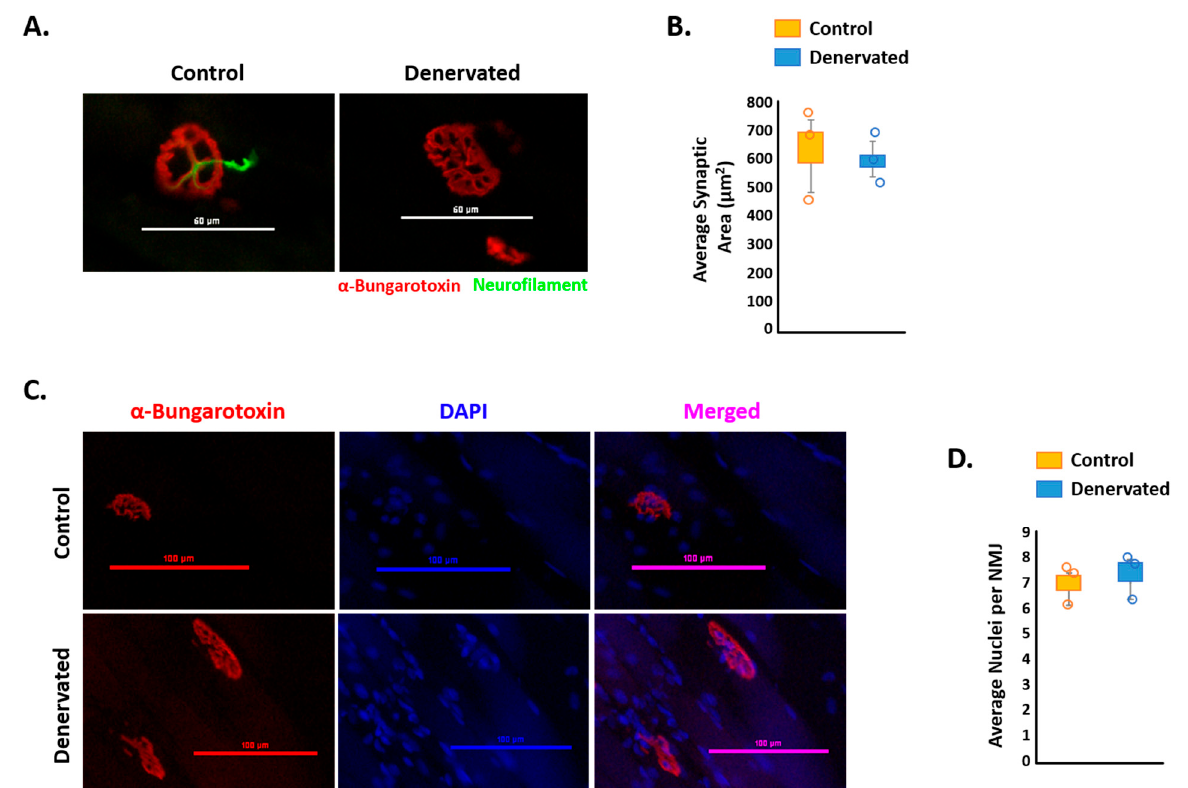
Figure 2. Effect of sciatic nerve transection on neuromuscular junction (NMJ) maintenance. ( A ) Representative images of the NMJ in the control and denervated GAS muscles immunostained with a snake toxin with a high affinity for AChRs ( α -bungarotoxin-tetramethylrhodamine) and neurofilament. Scale bar = 60 μ m. ( B ) Average synaptic area in the control and denervated GAS muscles. ( C ) Representative images of the NMJ using snake toxin with a high affinity for AChRs and nuclear staining (DAPI). Scale bar = 100 μ m. ( D ) Average nuclei per NMJ in the control and denervated GAS muscles. Values significantly different from the control mice by a paired two-tailed t -test.